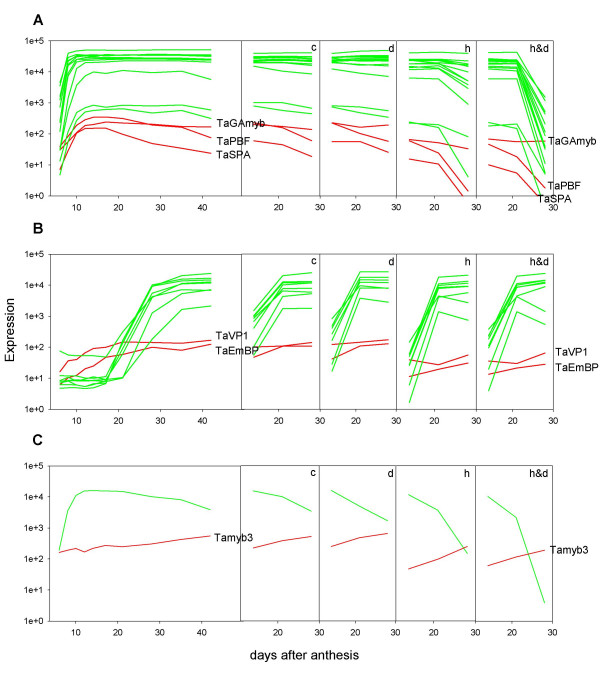
Comparison between expression of transcription factors (red lines) and their known targets (green lines). A: Transcripts of the TaSPA, TaPBF and TaGAmyb transcription factors and LMW glutenins. B: Transcripts of TaEmBP and TaVP1 transcription factors and Em proteins. C: Transcripts of HvMYB3-like transcription factor and BTI-CMe trypsin inhibitor protein.